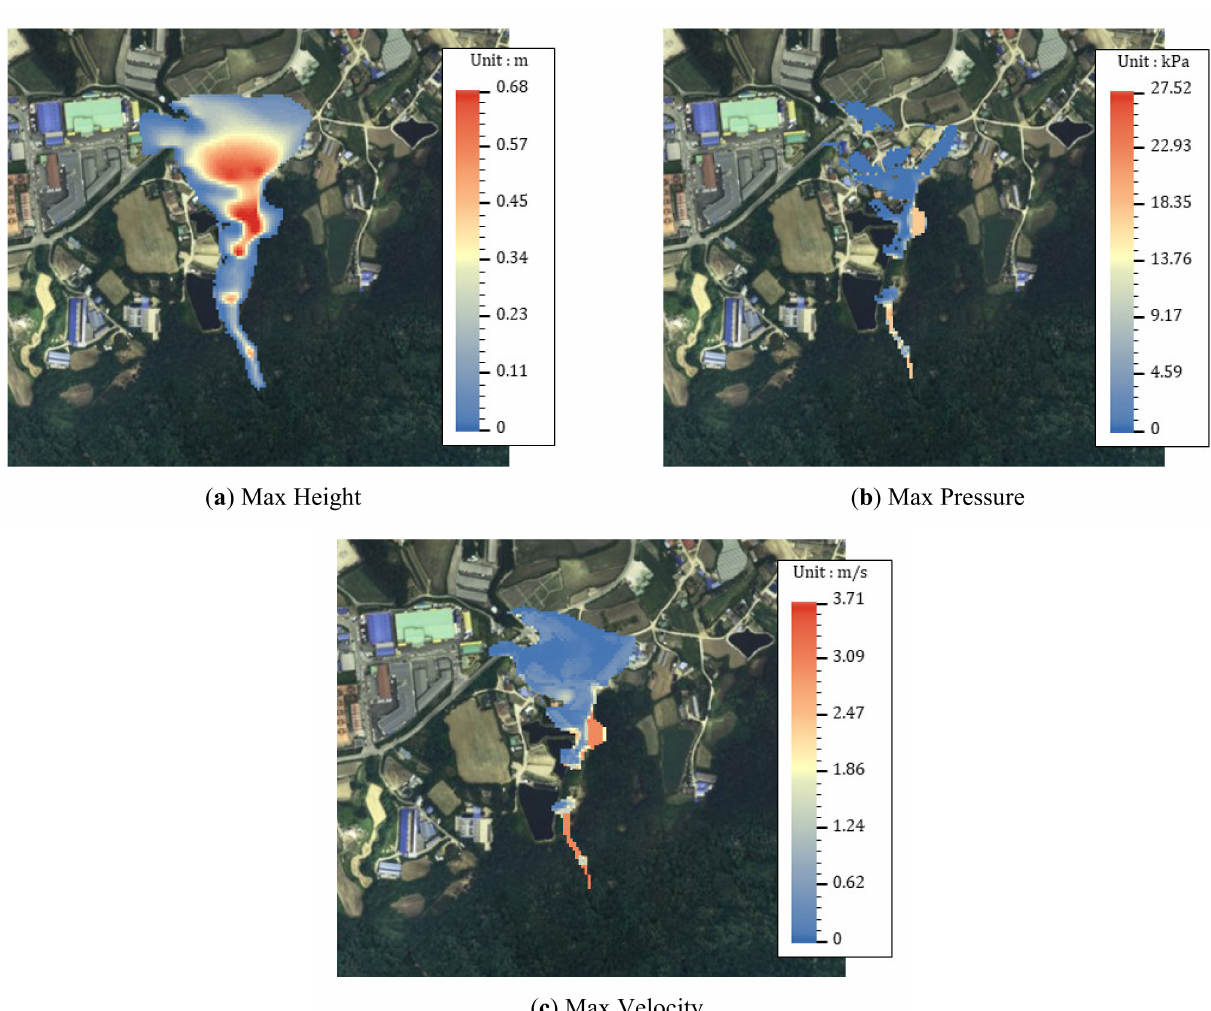
Figure 14. Results of RAMMS using HQPF—Event II. ( a – c ) are the Max Height (m), Max Pressure (kPa), and Max Velocity (m/s) in the modeling results of the debris flow in Namsan Village,